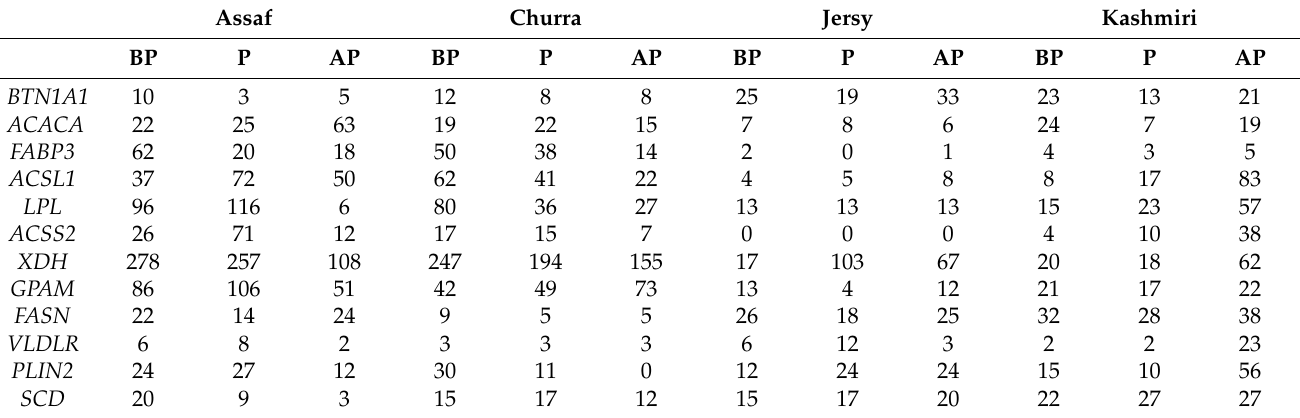
Table 7. Functionally annotated relevant variants in the milk fat candidate genes considered in this